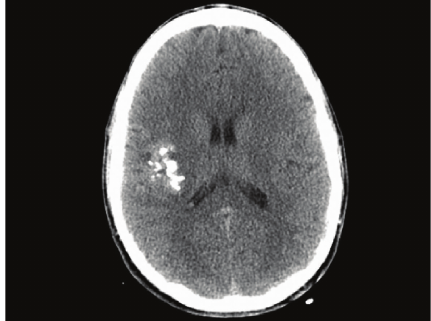
Figure 2: Axial CT without contrast demonstrates right posterosu- perior temporal lobe ill-defined clumped calcification.